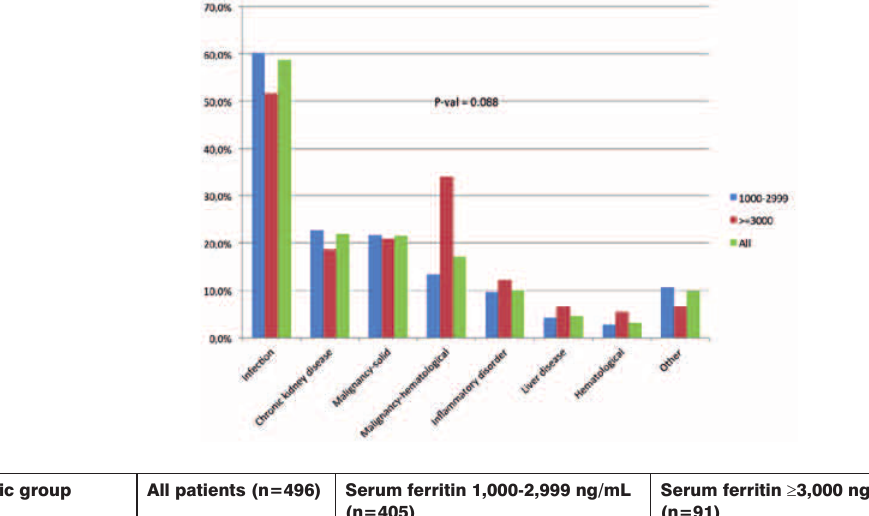
Figure 1. Final diagnostic groups